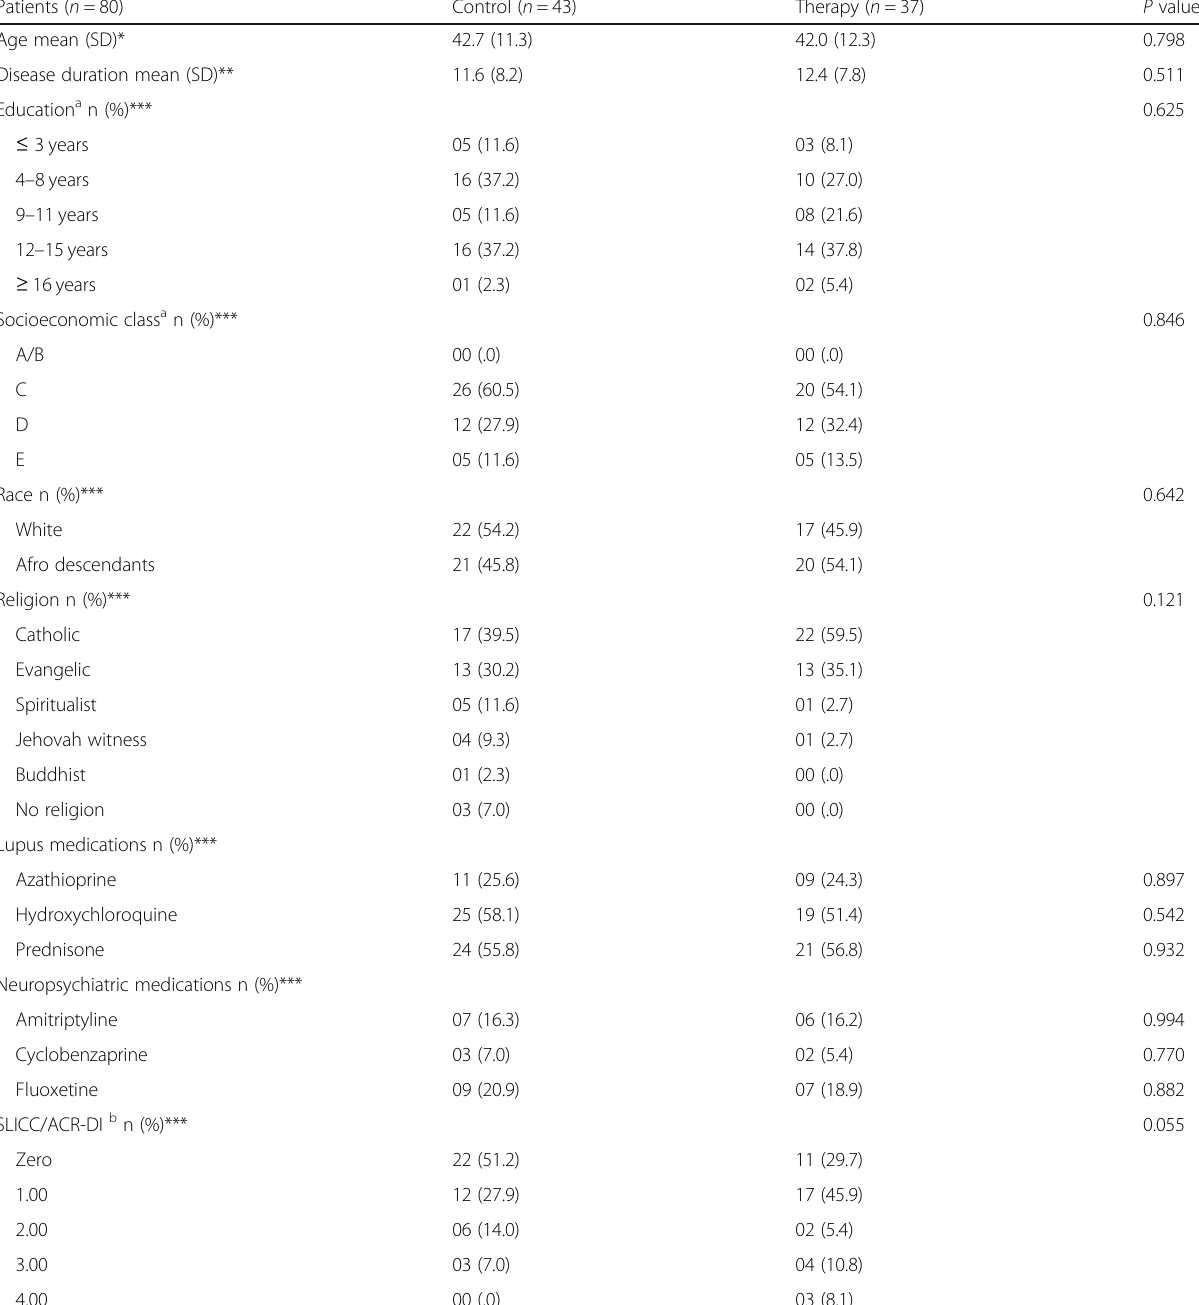
Table 1 Social, demographic and clinical data of SLE patients in control and therapy groups Patients ( n = 80) Control ( n =